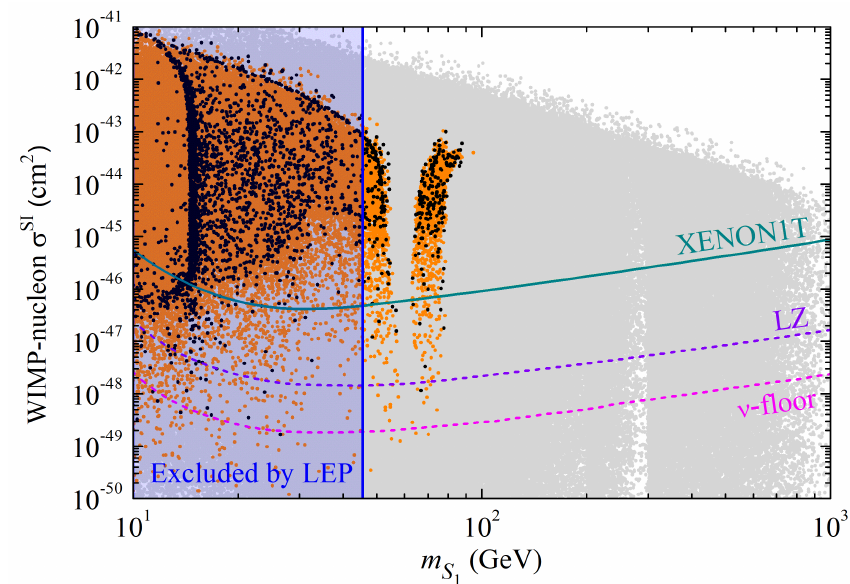
Figure 11 . WIMP-nucleon spin-independent elastic scattering cross-section σ SI as a function of the scalar DM mass m . We use the same colour code as in figure 9 to differentiate points in terms S 1 of their relic abundance and indicate the LEP excluded region. The solid turquoise line indicates the current bound from the XENON1T experiment [138], the dashed violet line represents the future sensitivity of the LUX-ZEPLIN (LZ) proposal [139] and the dashed magenta line shows the “neutrino floor” coming from coherent elastic neutrino scattering